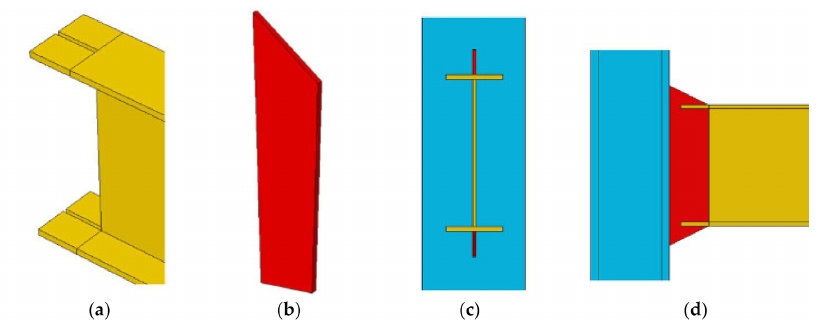
Figure 1. Connection with an absorber plate: ( a ) cut beam, ( b ) connection plate, ( c ) front view, and ( d ) side